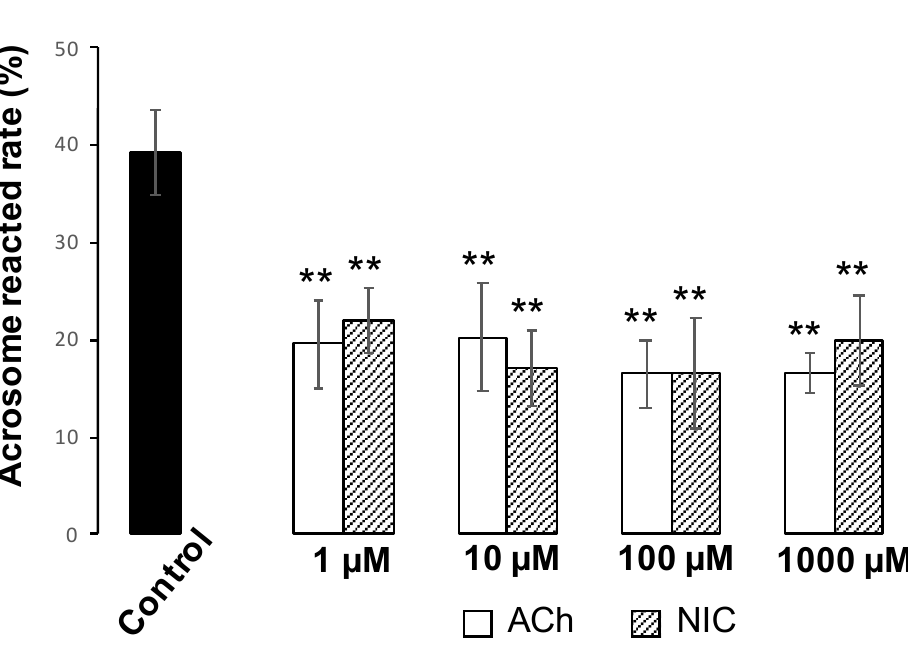
Figure 6. Effects of ACh and nicotine (NIC) on the sperm acrosome reaction. ACh and NIC administration suppresses AR. Mouse spermatozoa were capacitated in human tubal fluid (HTF) medium for 1 h. Phosphate-buffered saline (PBS) or various concentrations of ACh or NIC were added to equivalent aliquots of the suspension (200 µL, 5 × 10 6 cell/mL) and cultured for 3 h. All the groups contained 0.1% dimethyl sulfoxide (DMSO). Sperm acrosomal disappearance rates were evaluated by calculating the number of PNA-negative sperm out of the total counted sperm. Data shown as mean ± SD ( n = 3; ** p < 0.01).